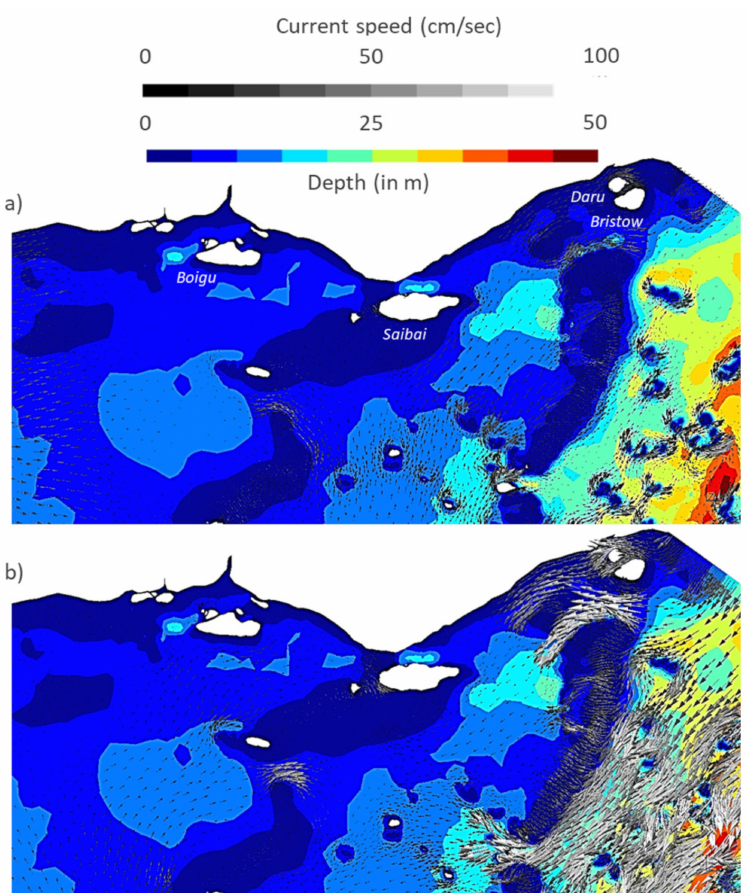
Figure A1. Tidally averaged currents under ( a ) monsoon wind (25 knots) and ( b ) strong SE winds (30 knots) modelled by the SLIM model ([23], unpublished